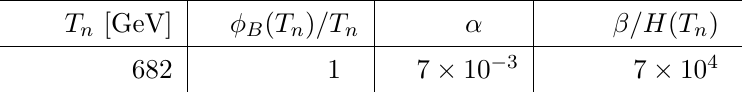
= 0 and v = 0 : 123. A =f b t